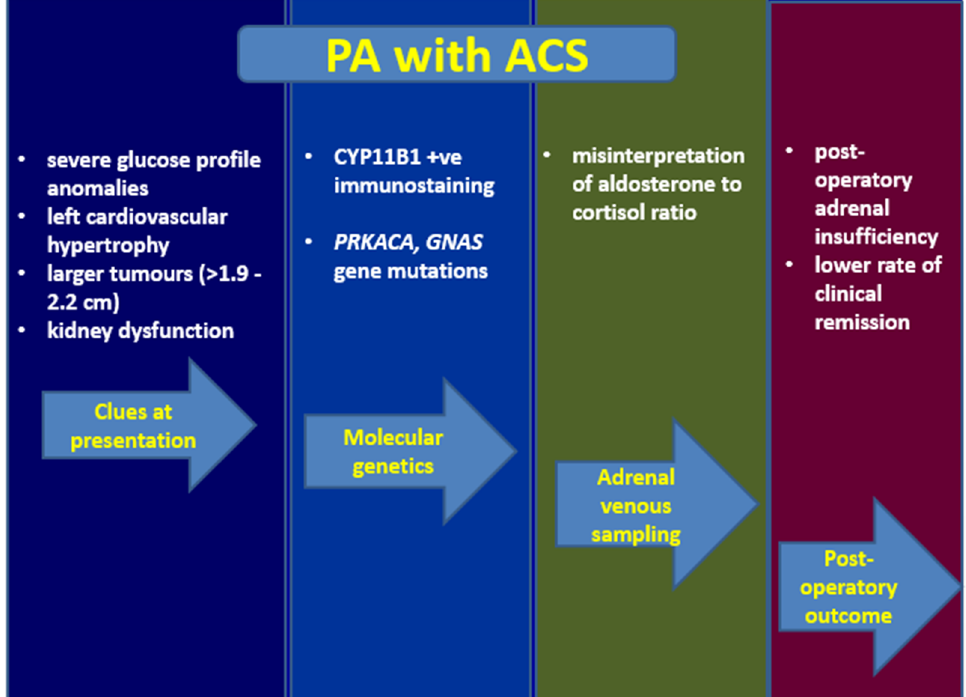
Figure 2. Overview of Connshing syndrome (primary hyperaldosteronim and autonomous cortisol secretion), from index of suspicion to post-adrenalectomy outcome (see references within the main text). Abbreviations: PA = primary aldosteronism; ACS = autonomous cortisol secretion; AVS = adrenal venous sampling.